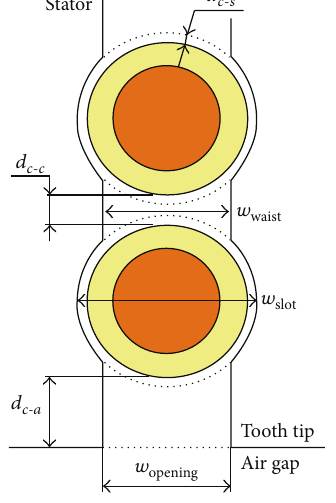
Table 2: Stator slot geometry of the reference machine compared to the suggested improved geometry.